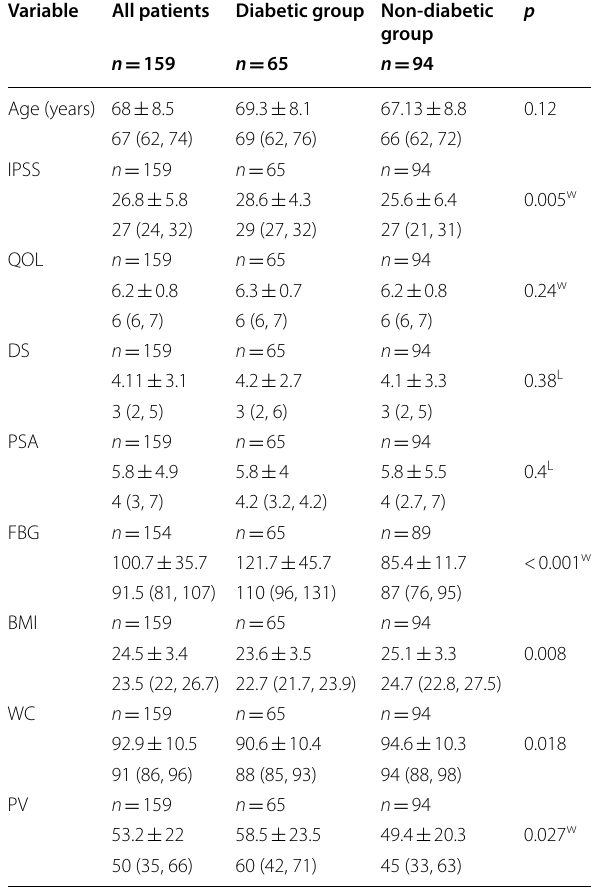
Table 1 Patients’